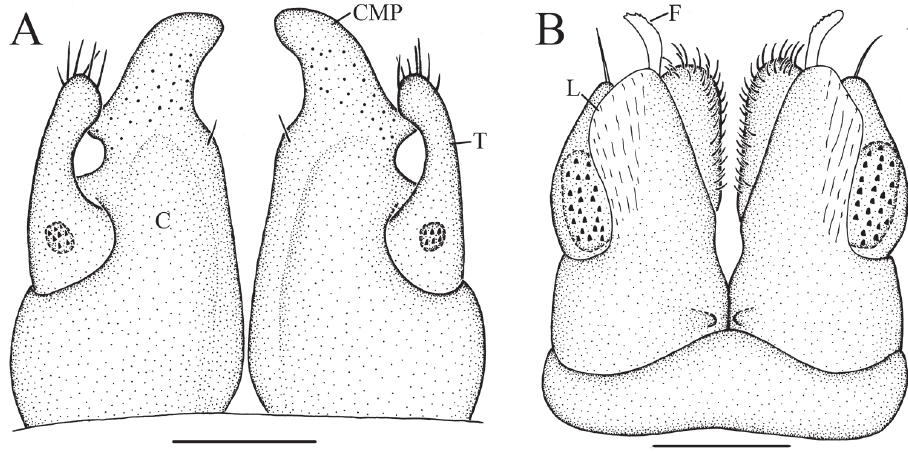
Figure 11. Glyphiulus calceus sp. n., holotype. A anterior gonopods, caudal view B posterior gonopods, caudal view. Abbreviations: C = coxosternum; CMP = coxosternal mesal process; F = flagellum; L = lamel- liform lobe; T = telopodite. Scale bars: A, B 0.2